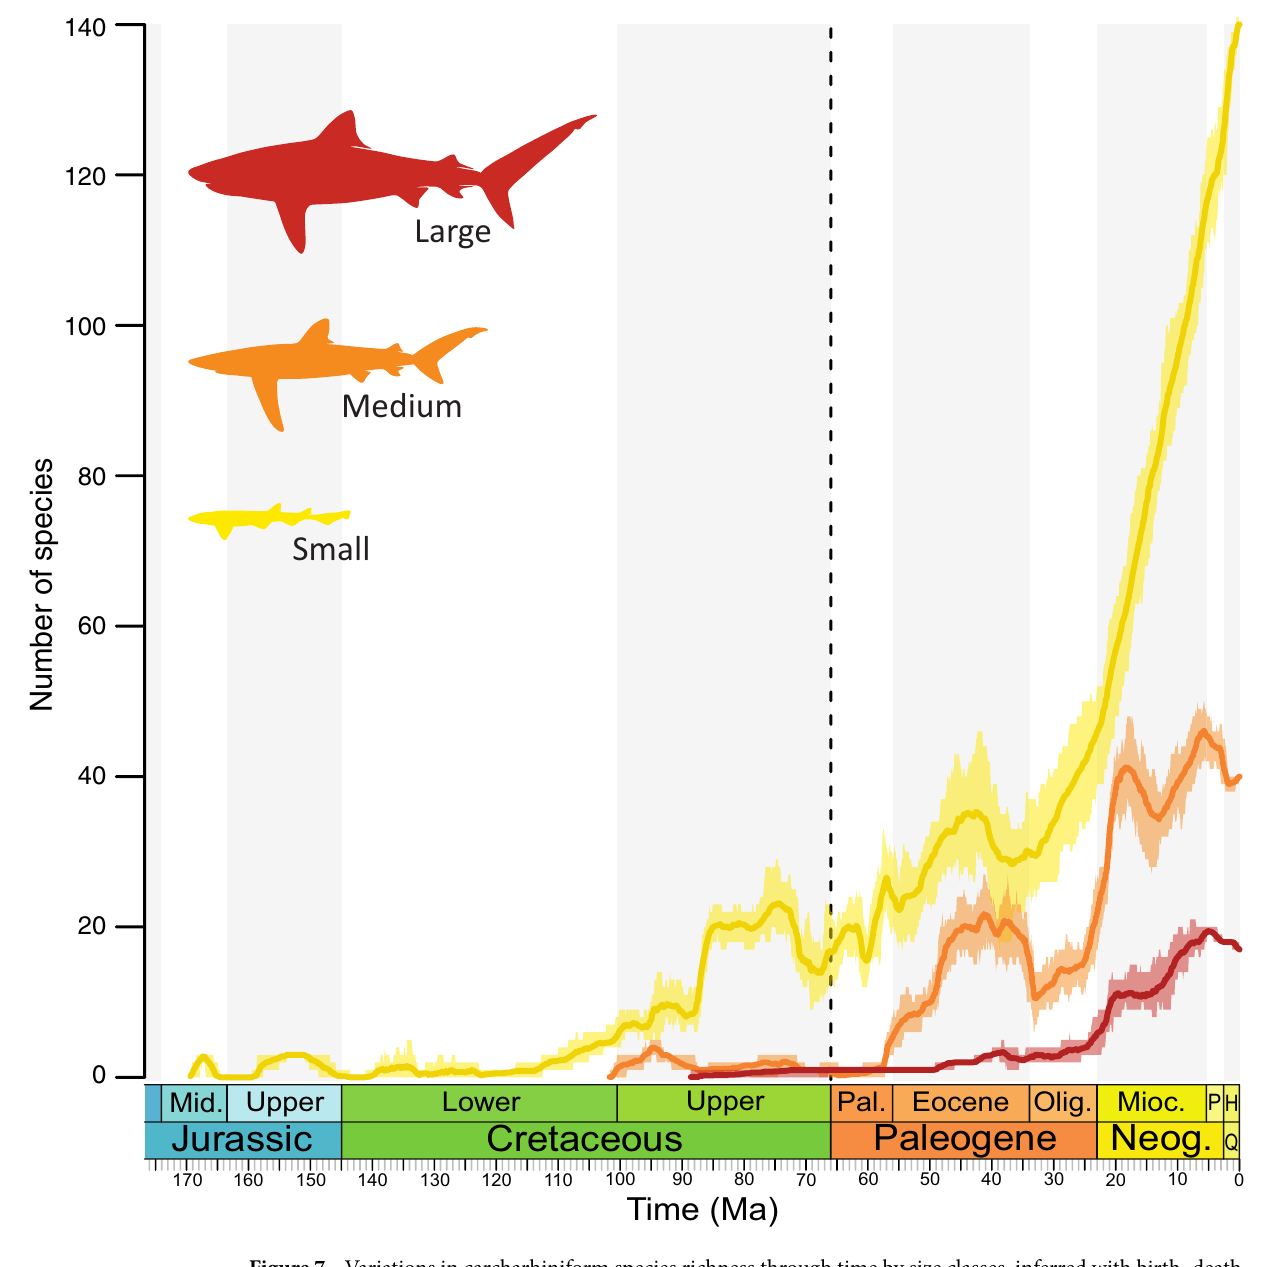
Figure 7. Variations in carcharhiniform species richness through time by size classes, inferred with birth–death model with constrained shifts (BDCS-Combined, shifts every 10 Myrs) using combined fossil and phylogeny datasets. Solid lines indicate mean diversity and the shaded areas show 95% HPD. Complete rate estimates (extinction, speciation, and net diversification) for each size class are available in Supplementary Data